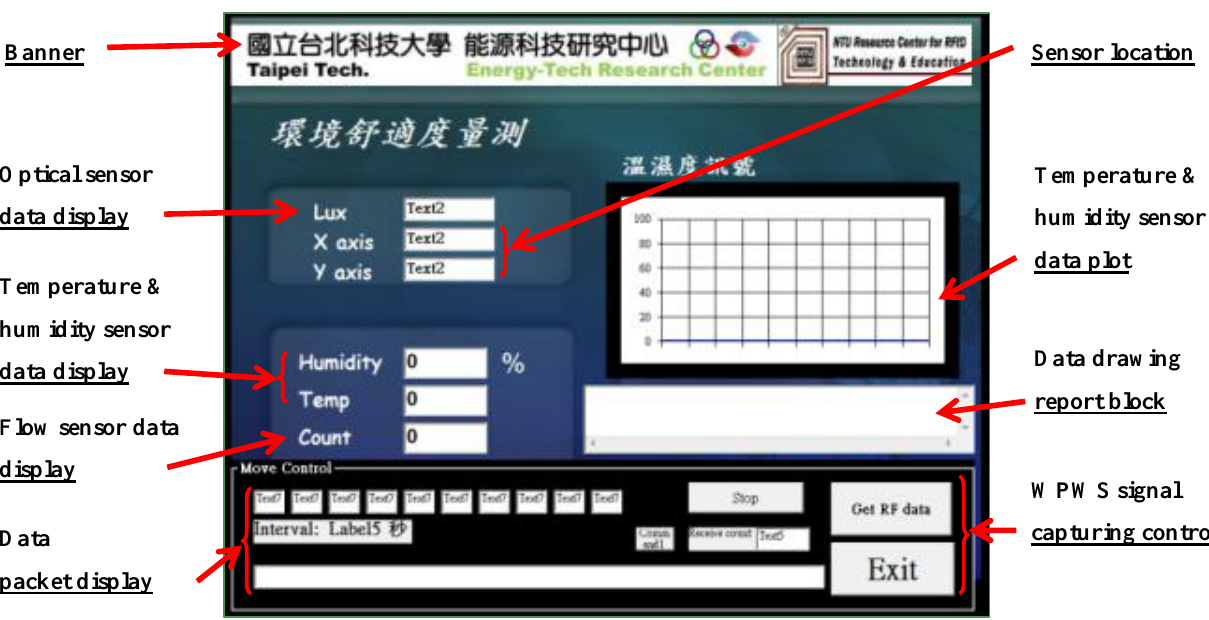
Figure 12. The software used to display sensing data, record communication packets, and evaluate the stability of the